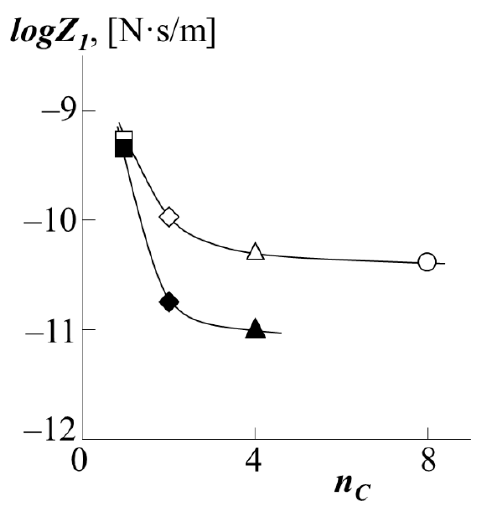
Figure 12. Dependence of the friction coefficients during the movement of PS-1 (white dots) or PS-2 (black dots) into the matrix of PBA (triangle), PEA (rhombus), PMA (square) or PEHA (circle) on the number of carbon atoms in the side chains of polyacrylate n C at 433 K.